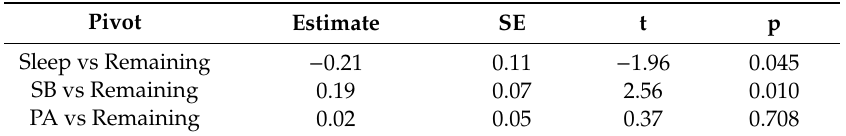
Table 2. Regression of pivot coordinates against body mass index z-score among n = 3228 children, Wave 6 LSAC birth cohort. Pivot Estimate SE t p Sleep vs Remaining − 0.21